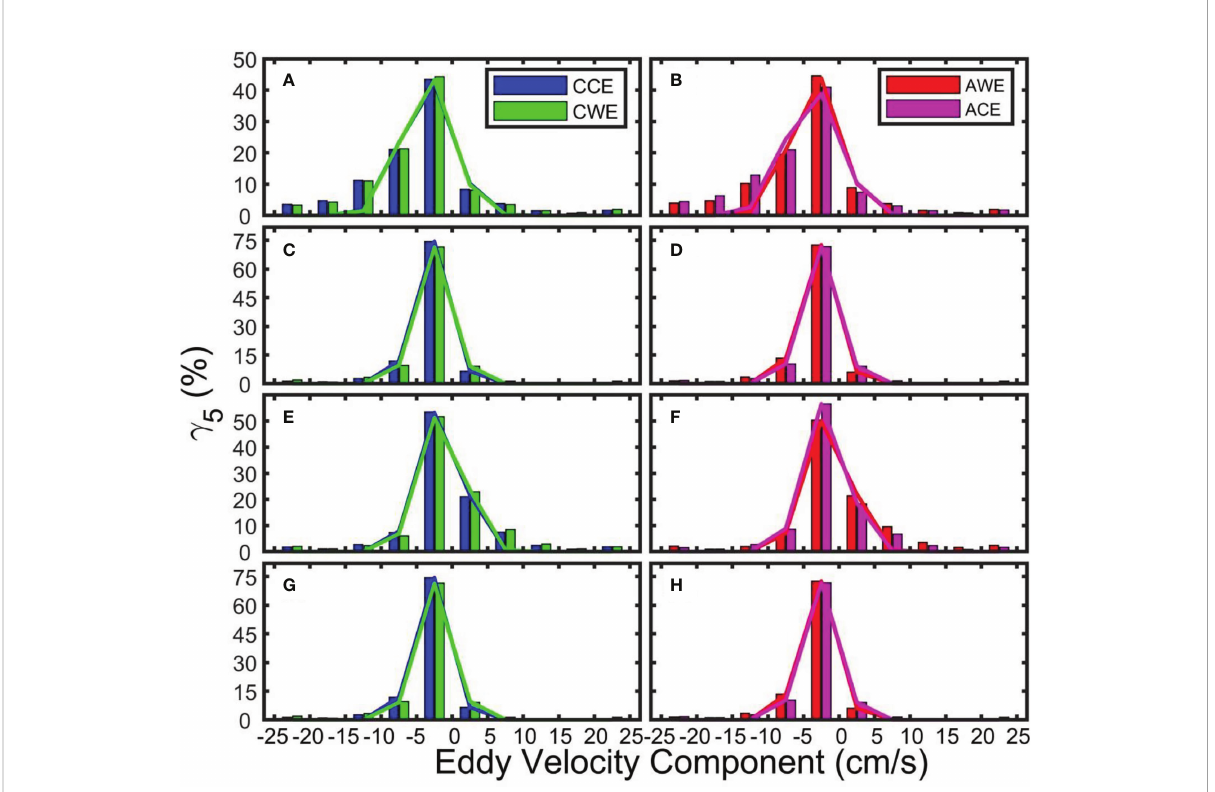
FIGURE 11 Statistical histogram of zonal (A – D) and meridional (E – H) eddy velocity at the sea surface (A, B, E, F) and at 1,000 m ( C , D , G , H , units: cm/s). Blue, red, green, and magenta bars represent cyclonic cold-core eddy, cyclonic warm-core eddy, anticyclonic warm-core eddy, and anticyclonic cold-core eddy, respectively. Eastward and northward are positive, and westward and southward are negative. The curves show the distribution of the Gaussian fi tting